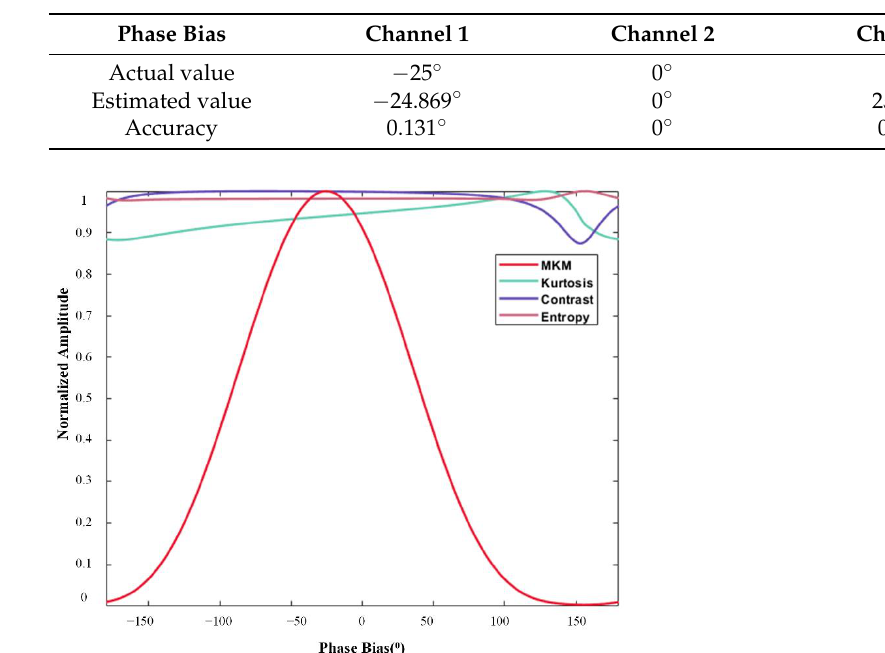
Figure 5. ( a ) Azimuth profile with phase bias. ( b ) Azimuth profile after calibration. Table 2. Channel phase bias estimation results.